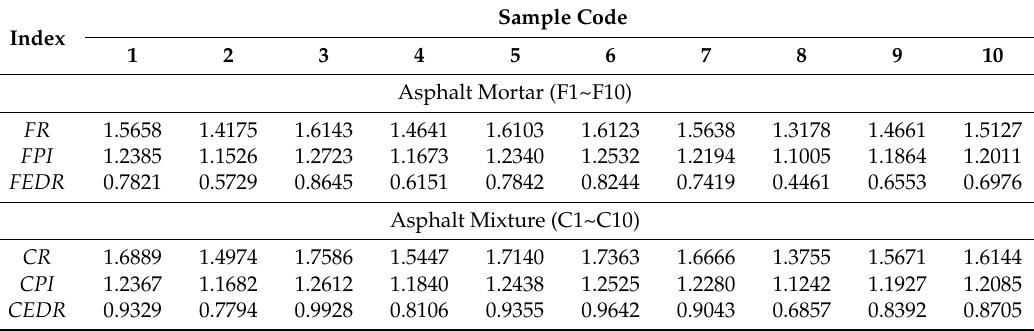
Table 4. Composite morphological index of fine and coarse